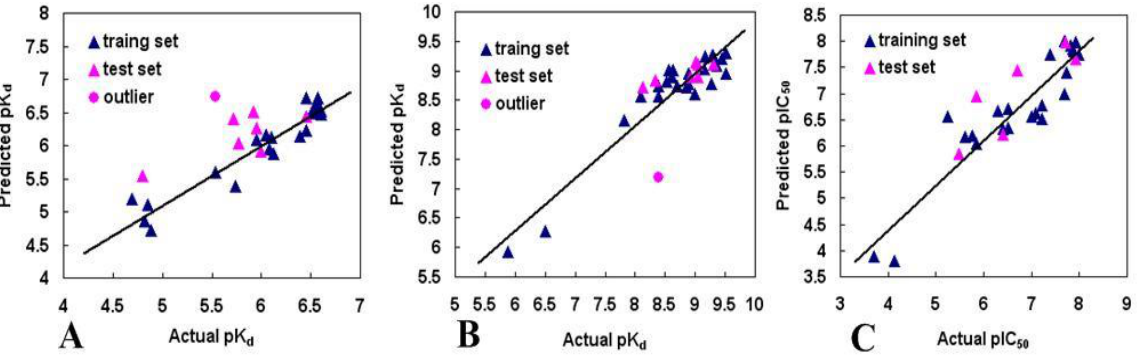
Figure 4. Plot of the predicted p IC ( A ) COMFA model of benzamide tetrahydro-4 H -carbazol-4-one analogs; ( B )